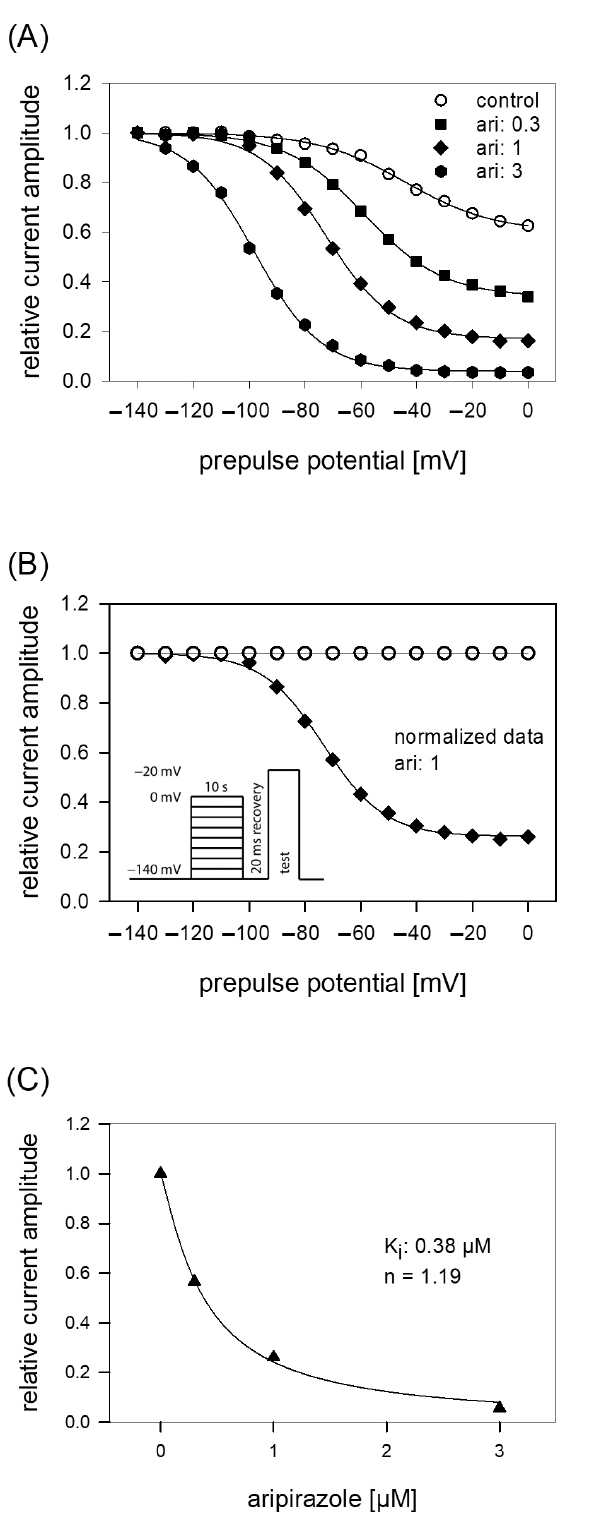
Figure 5. Voltage dependence of slow inactivation. ( A ) Data of normalized peak currents from a representative cell are plotted versus the prepulse potential. Solid lines are fits according to Equation (5) for control (open circles) and different concentrations of aripiprazole (filled symbols). The experimental scheme as illustrated by the insert of B consisted of channel activations to − 20 mV after long ‐ lasting (10 s) conditioning prepulses to different potentials and a short (20 ms) recovery period at − 140 mV immediately before the test pulse. ( B ) Normalized data for 1 μ M aripiprazole were ob ‐ tained by dividing the values obtained in the presence of 1 μ M aripiprazole by those obtained for control. It is evident that current amplitudes continuously decreased with an increase in prepulse potential. ( C ) Concentration response curve taken from normalized current amplitudes obtained at